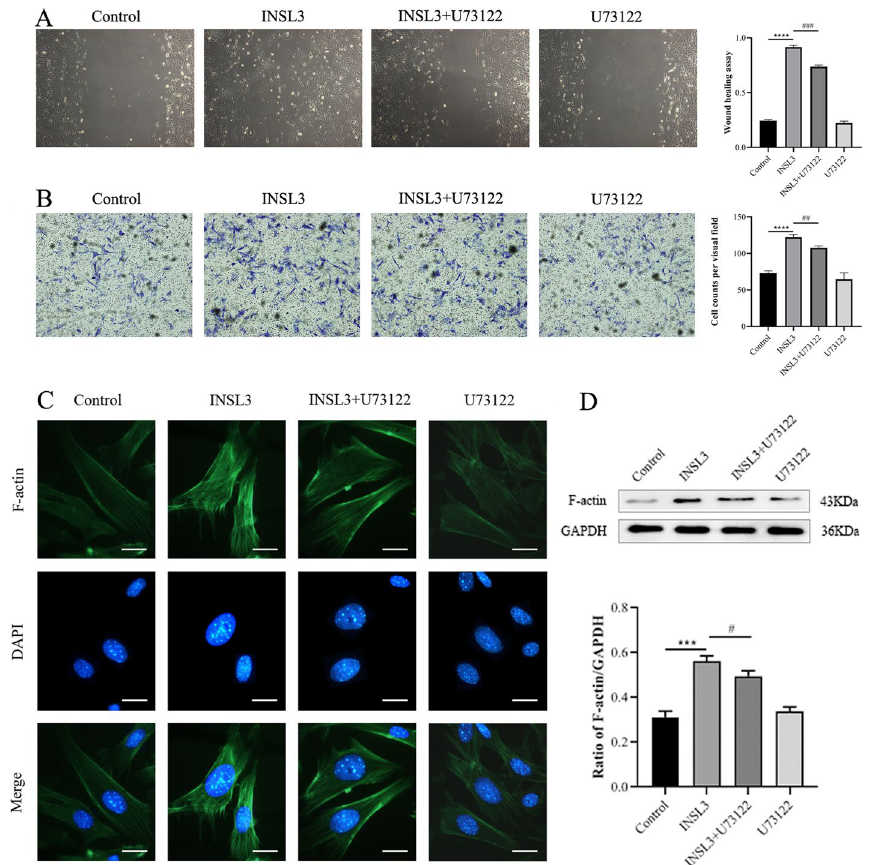
Fig. 2 U73122 mediated the effect of INSL3 on the migration ability of gubernacular cells. A, B The scratch and transwell tests assessed gubernacular cell migration in each group. C, D The expression of fibrous actin (F-actin) protein was analyzed by immunofluorescence staining and Western blot. Scale bars, 20 μm. Data are mean standard deviation of three independent experiments. * &# P < 0.05, ** &## P < 0.01, *** &### P < 0.001, and ± **** &#### P <